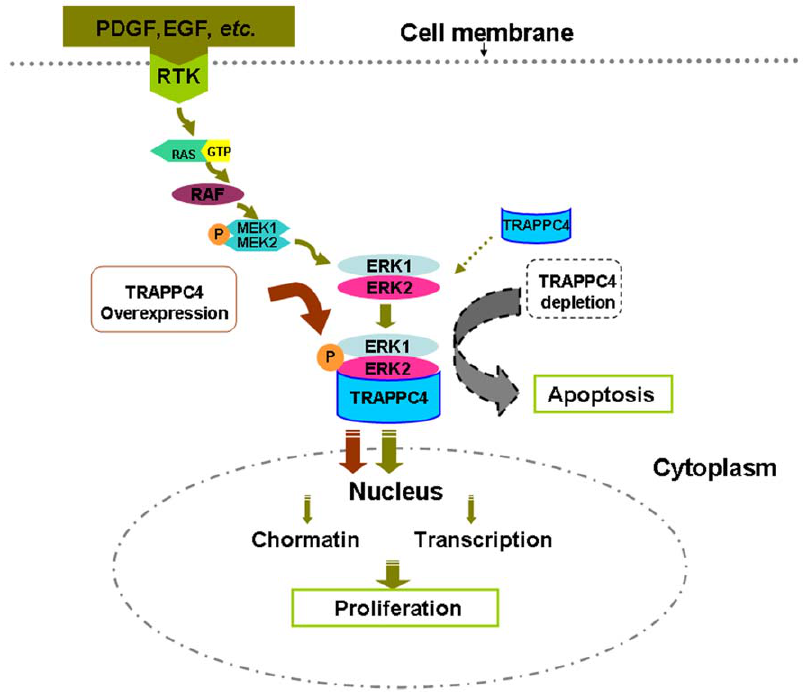
Figure 7. The speculated role of TRAPPC4-ERK2 interaction in CRC. Extracellular signals, such as PDGF, activate ERK cascades(RAS/RAF/MER/ ERK) through receptor tyrosine kinases (RTKs) and utimately regulate cell proliferation and apoptosis. TRAPPC4 binds and activates ERK1/2 as well as participates in the nuclear transport of pERK1/2. When TRAPPC4 is depleted, less ERK1/2 is phosphorylated, and relatively more pERK1/2 remains in the cytoplasm, which leads to suppression of cell proliferation and apoptosis. When TRAPPC4 is overexpressed, more ERK1/2 is activated, and even more is transported into the nucleus, finally leading to increased cell growth.